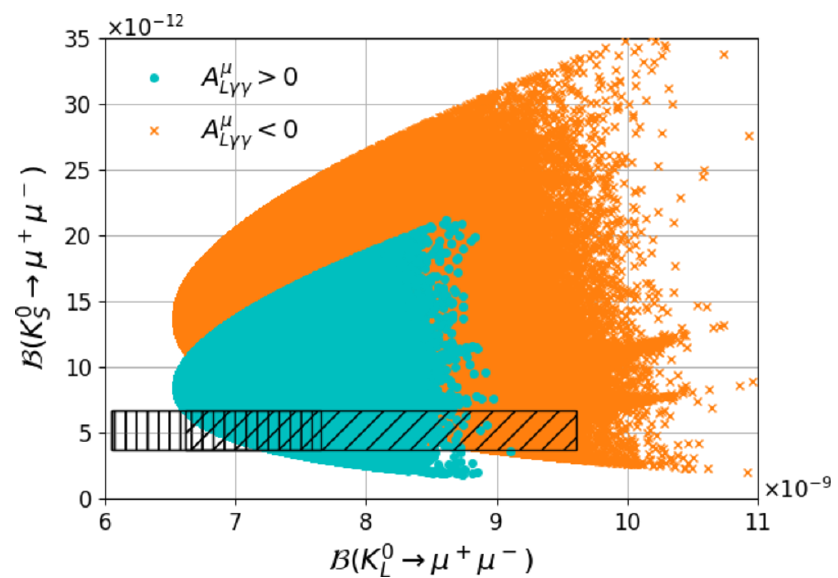
Figure 3 . A generic scan of ( K 0 (cid:22) + (cid:22) (cid:0) ) vs. ( K 0 (cid:22) + (cid:22) (cid:0) ) from ref. [33], in an MSSM S ! L ! B B scenario with universal gaugino masses. The cyan dots correspond to predictions with A (cid:22) and the orange crosses to predictions using A (cid:22) < 0. The vertically hatched area corresponds to L(cid:13)(cid:13) the SM prediction for A (cid:22) > 0 while the diagonally hatched area corresponds to the SM prediction L(cid:13)(cid:13) for A (cid:22) < 0. L(cid:13)(cid:13)